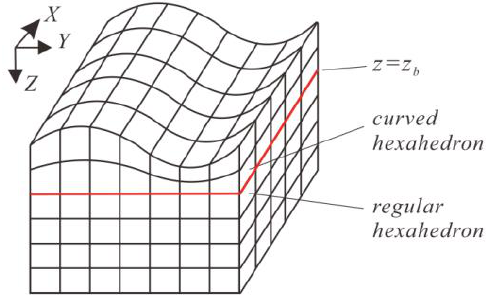
Figure 2. Schematic diagram of combined hexahedral grid.